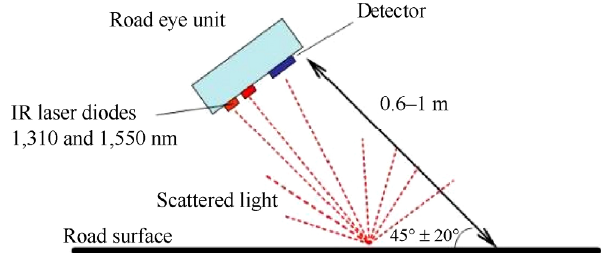
Fig. 3 The schematic of using optimal sensor to identify different surfaces [23].